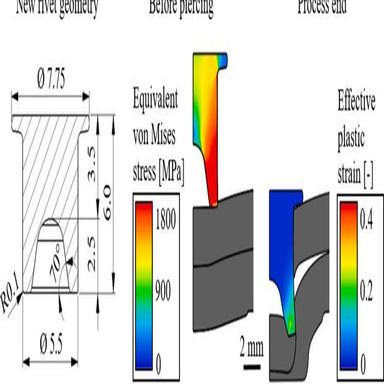
Geometrical properties of the new rivet and joining result with the new rivet.